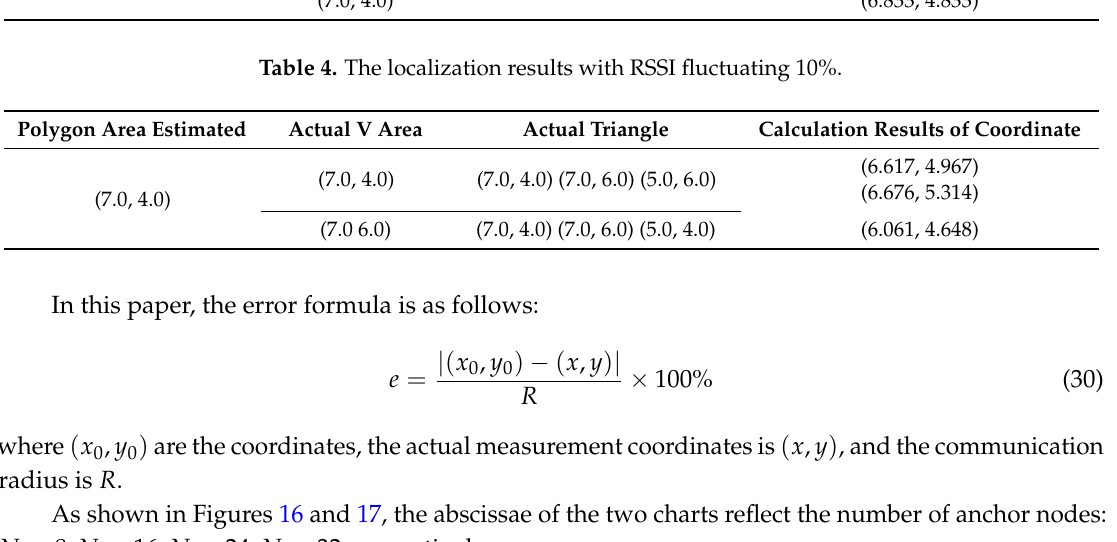
Table 4. The localization results with RSSI fluctuating 10%.